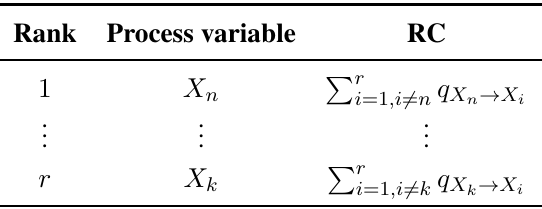
Table 1. Root cause priority list from the causal